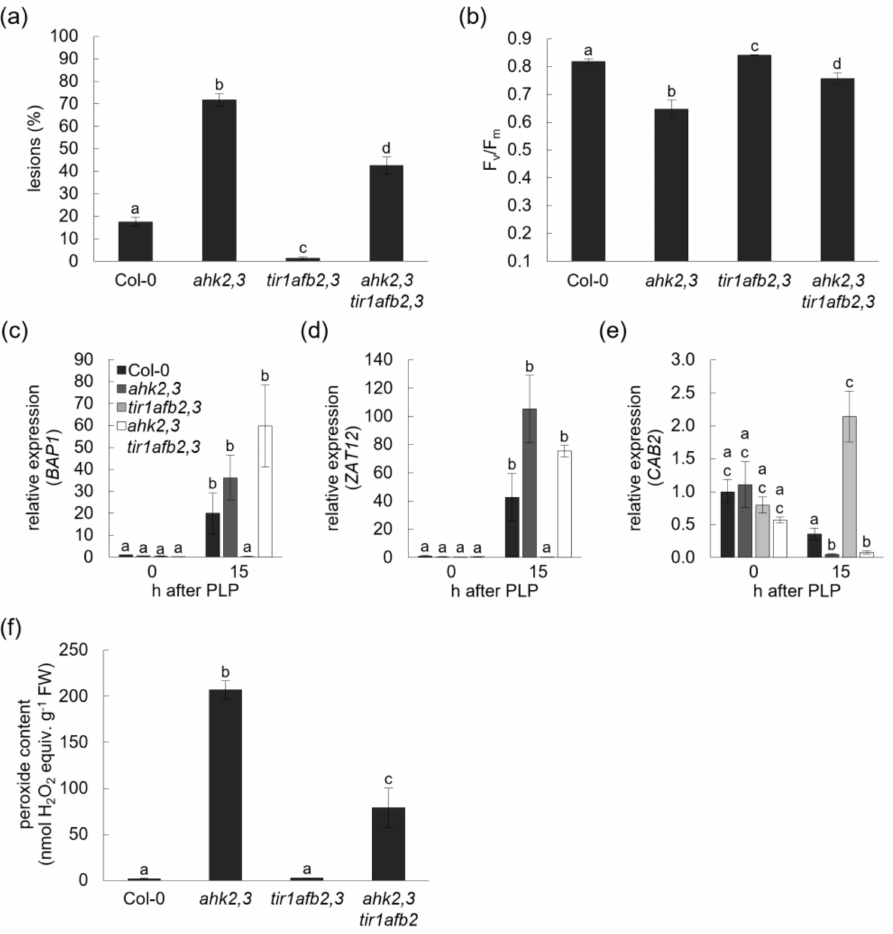
Figure 5. An impairment of auxin perception decreases the sensitivity to photoperiod stress. ( a ) Lesion formation of leaves in five-week-old Col-0, ahk2,3 , tir1afb2,3 and ahk2,3 tir1afb2,3 plants the day after the photoperiod stress treatment (one-way ANOVA; p ≤ 0.05; n ≥ 12). ( b ) Efficiency of photosystem II (F v /F m ) of leaves the day after photoperiod stress treatment (paired Wilcoxon test, FDR corrected via Benjamini–Hochberg method; p ≤ 0.05; n ≥ 13). Transcript abundance of BAP1 ( c ), ZAT12 ( d ) and CAB2 ( e ), 0 and 15 h after the PLP treatment compared to respective control plants. The expression level of wild type at the end of the PLP treatment (0 h) was set to 1 (one-way ANOVA; p ≤ 0.05; n ≥ 3). ( f ) Peroxide content expressed as nmol H 2 O 2 equivalents g − 1 FW in Col-0, ahk2,3 , tir1afb2,3 and ahk2,3 tir1afb2 leaves 15 h after PLP treatment (one-way ANOVA; p ≤ 0.05; n = 4). Letters indicate significantly different statistical groups. Pictures of representative plants exposed to a 24 h prolongation of the light period are shown in Supplementary Figure